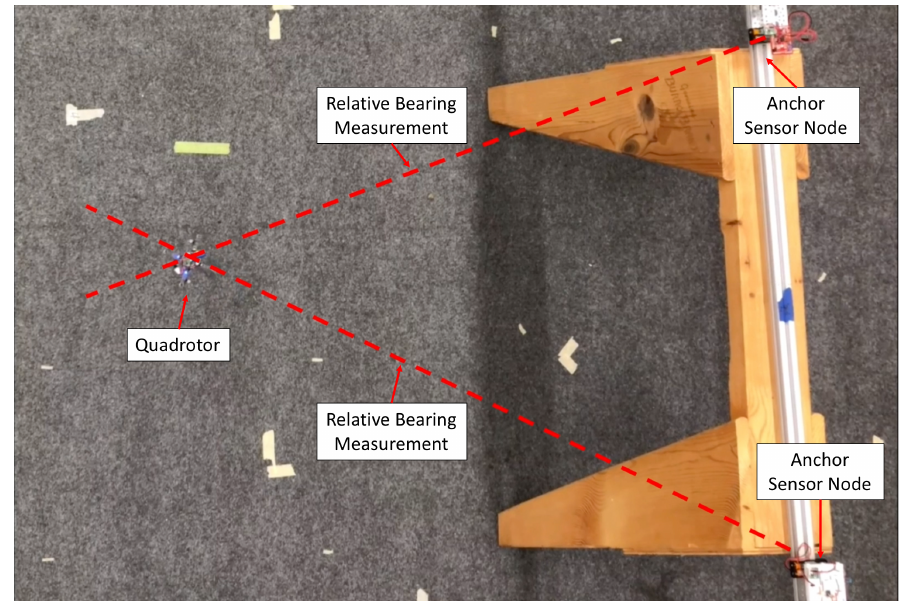
Figure 9. Setup of localization experiment. This is a top-down view of the experiment, and the motion capture cameras are not